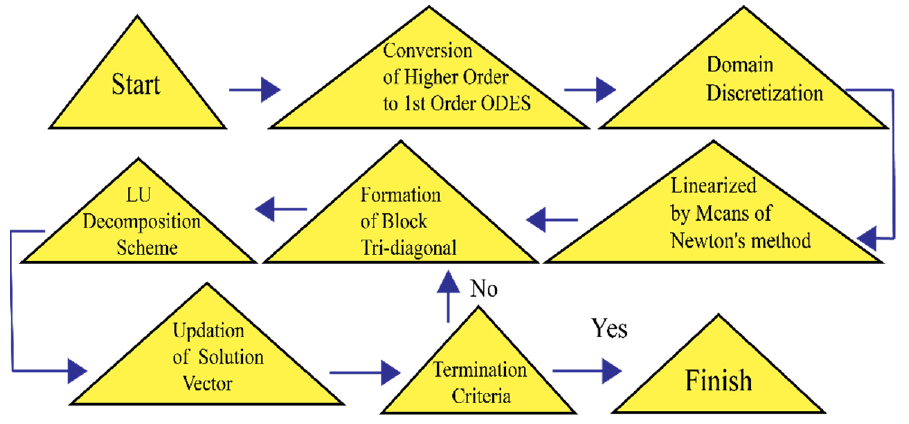
Figure 4. Flow chart of Keller-box method.